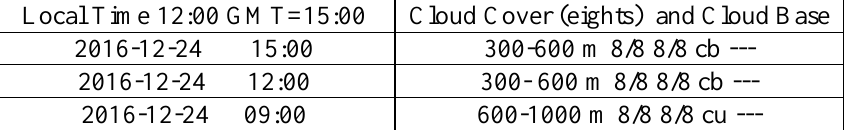
Table 5: Surface weather forecast for Baghdad.